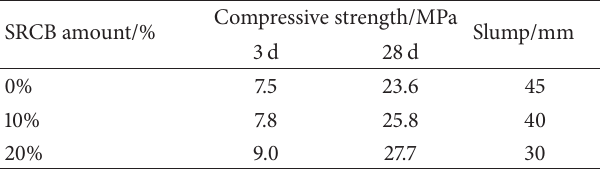
Figure 6: Morphology of hardened paste. Table 2: Compressive strength and slump of concrete with WRB